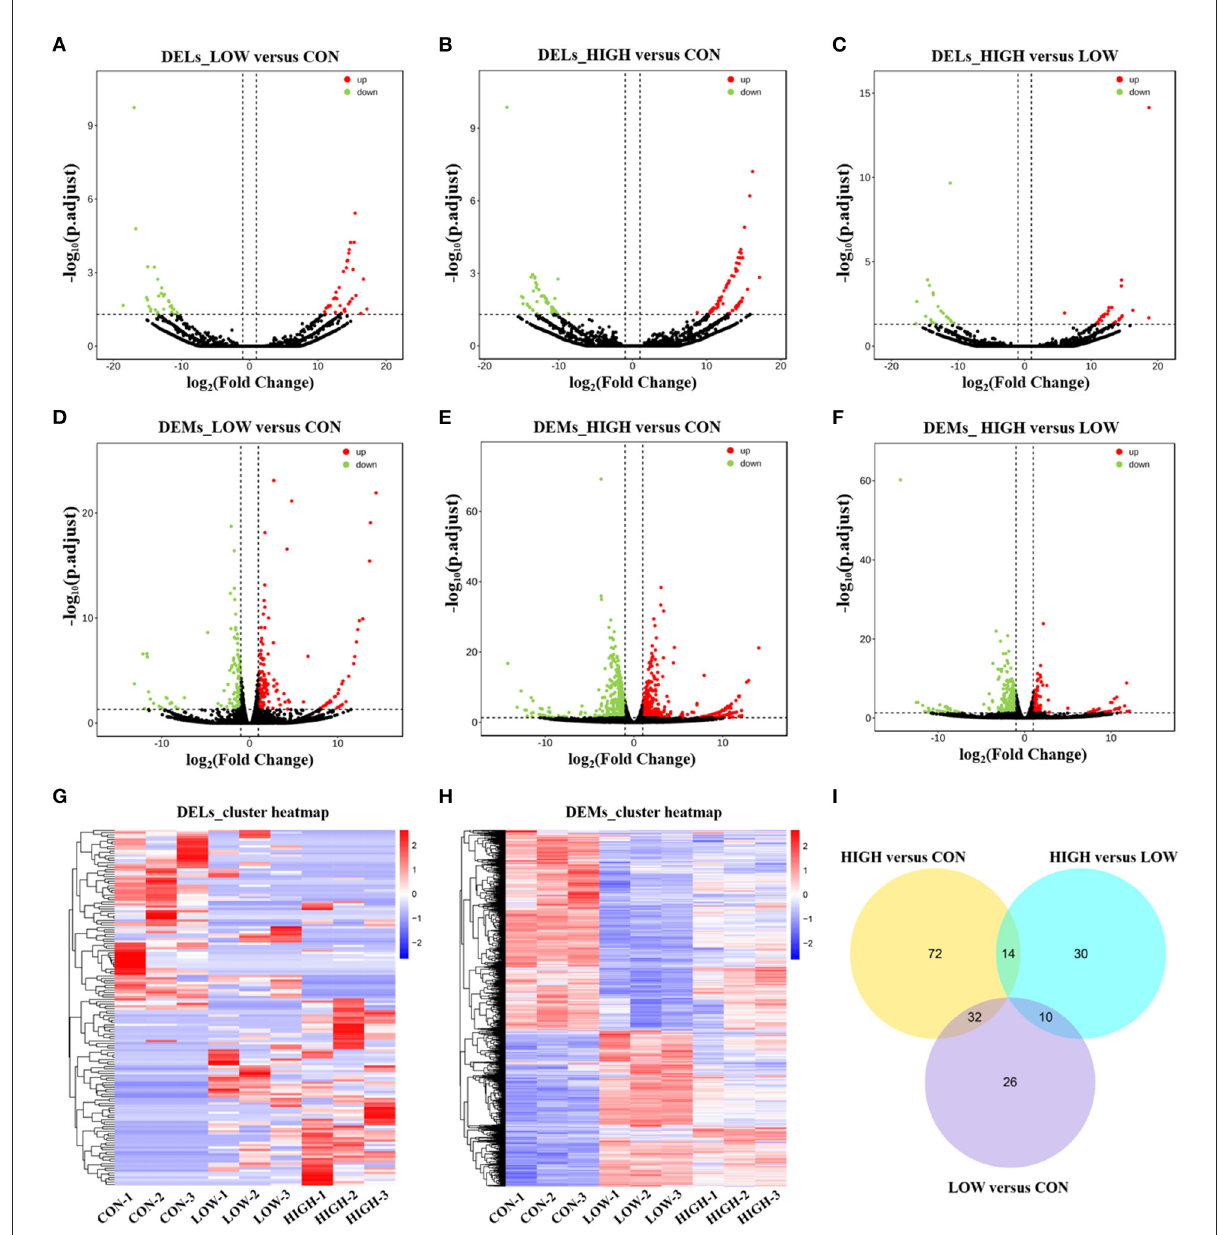
FIGURE4 Expression Profiles of lncRNAs and mRNAs in POGCs. (A–C) Volcano plot indicating up– and downregulated lncRNAs of POGCs in different RES treatment groups (LOW vs. CON, HIGH vs. CON, HIGH vs. LOW); up– and downregulated genes are colored in red and green, respectively. (D–F) Volcano plot indicating up– and downregulated mRNAs of POGCs in different RES treatment groups (LOW vs. CON, HIGH vs. CON, HIGH vs. LOW); up– and downregulated genes are colored in red and green, respectively. (G, H) Heatmap of lncRNAs (G) and mRNAs (H) showing hierarchical clustering of changed lncRNAs and mRNAs of POGCs in different RES treatment groups; up– and downregulated genes are colored in red and blue, respectively. (I) Venn diagrams of DELs in response to different treatments.